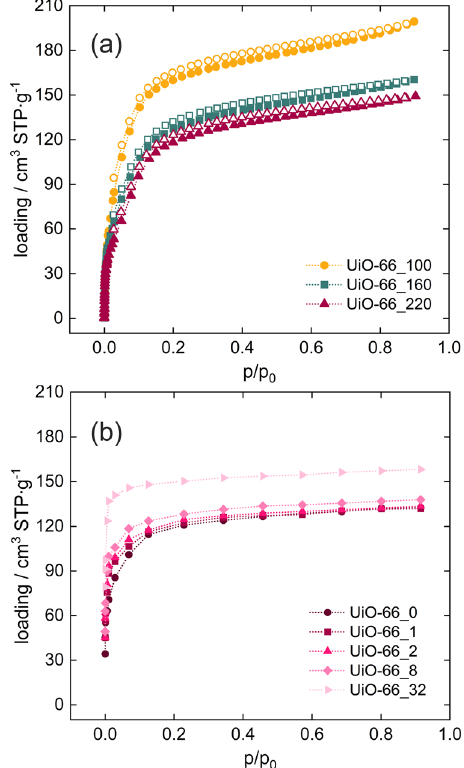
Fig. 4 Adsorption isotherms of ethanol in UiO-66. a From experiment, b from calculations, measured/computed at 27 °C. Closed symbols stand for adsorption, open for